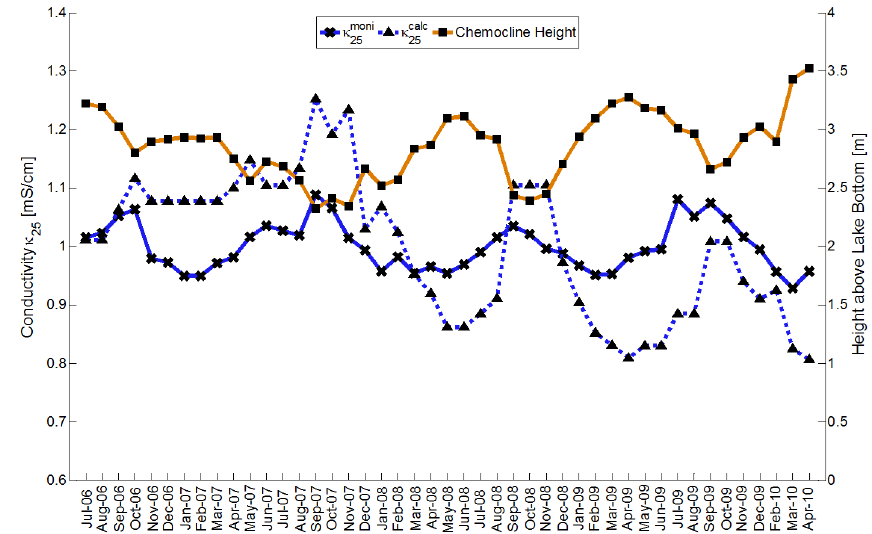
Figure 9. Comparison of time series of measured and calculated average electrical conductivity ( κ 25 ) in the